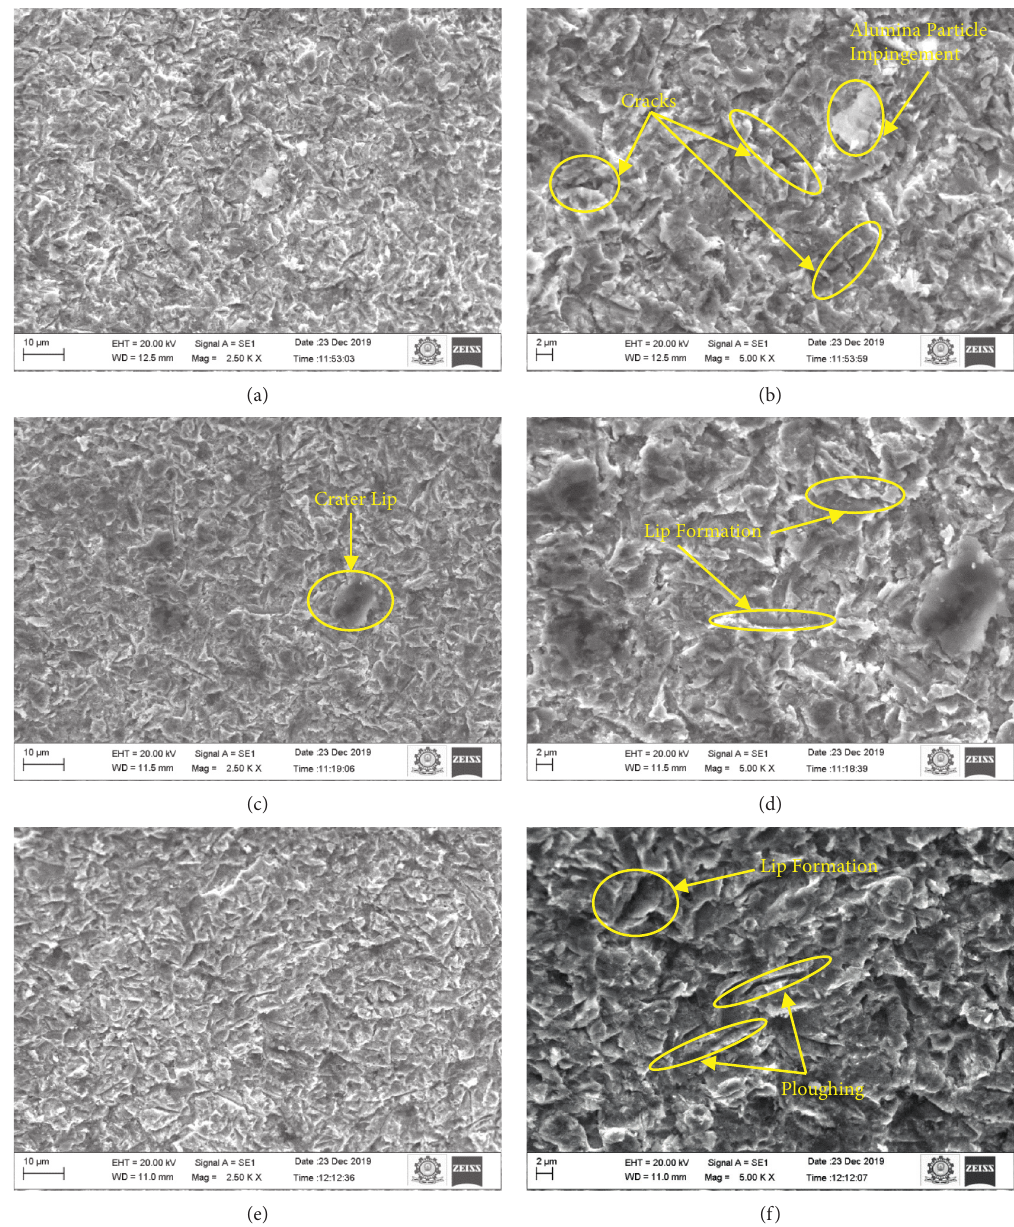
Figure 7: The higher and lower magnification of erosion morphology for the angle 90 ° for (a, b) Bare, (c, d) HT 1, and (e, f) HT